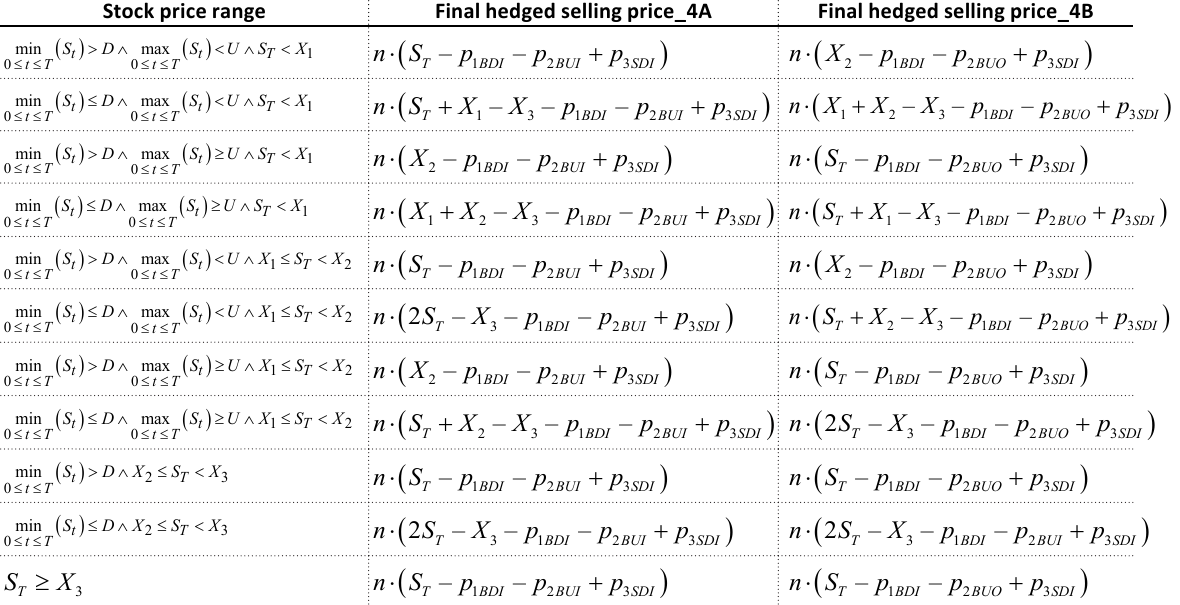
Table 5. Final hedged selling prices using Short Put Ladder option strategy_4